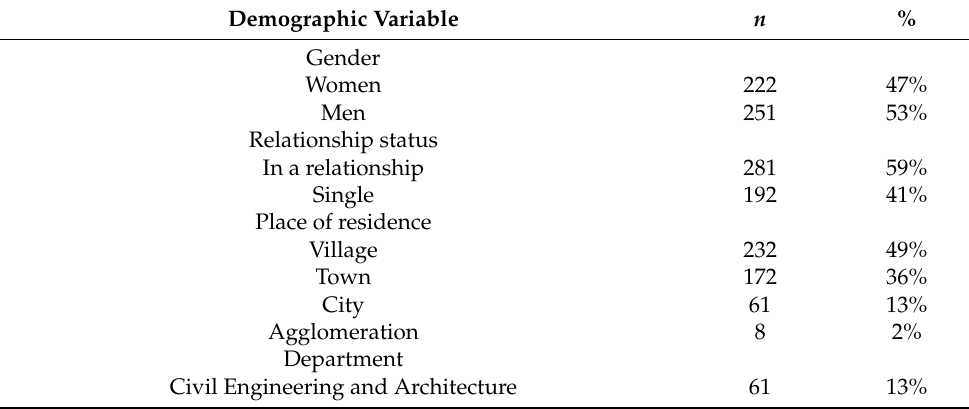
Table 1. Demographic characteristics of the